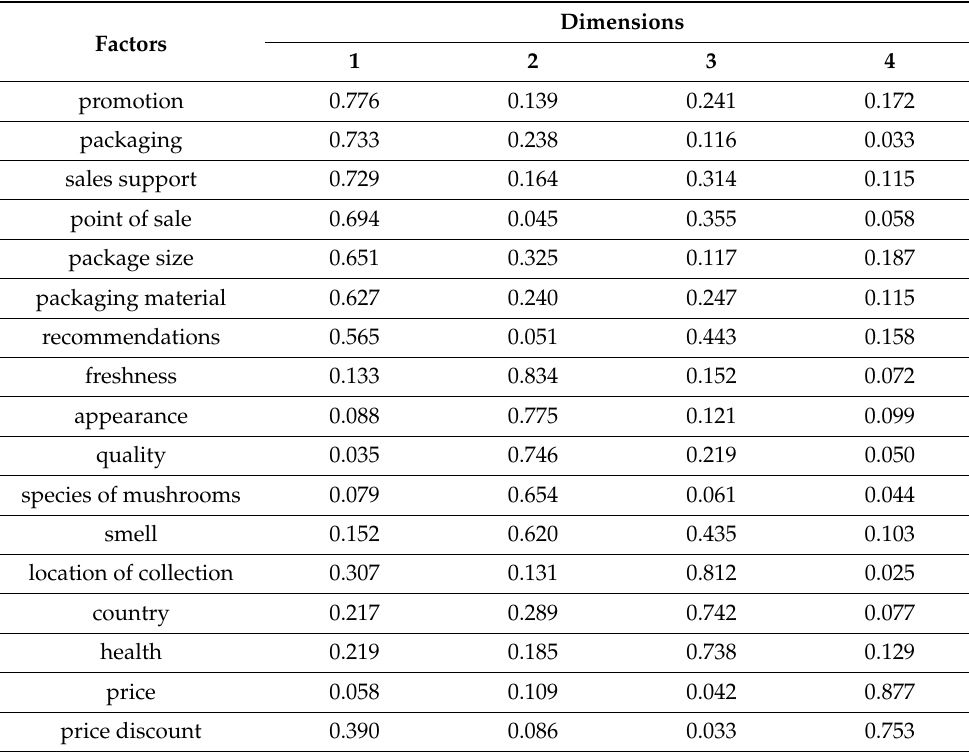
Table 10. Factor loadings from Categorical Principal Component Analysis (CATPCA)—Factors determining edible mushrooms purchase and